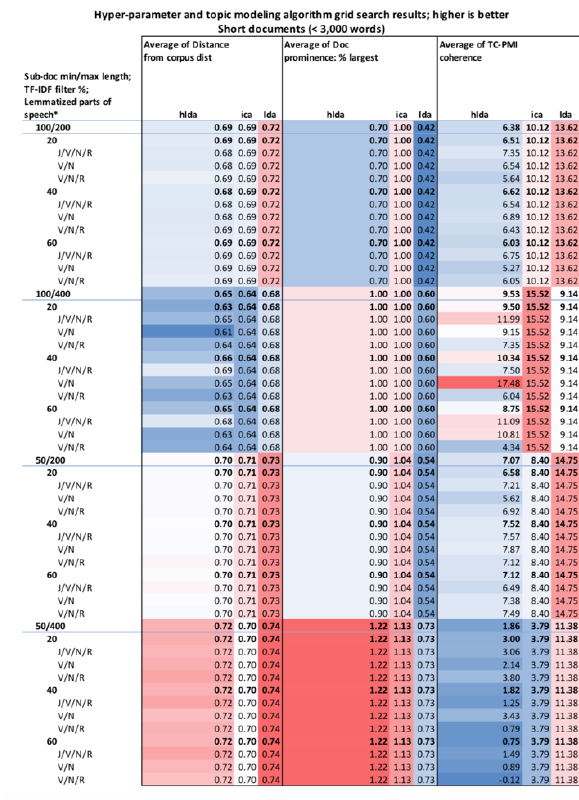
Figure 13. Hyper-parameter testing results, short documents